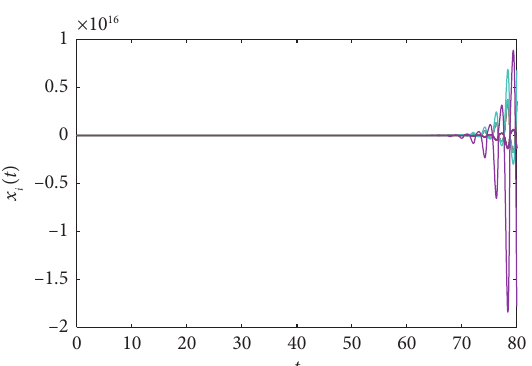
Figure 1: States of fuzzy neural networks (8) without pinning control ( L ( 1 ) � L ( 2 ) � 0 ) : z